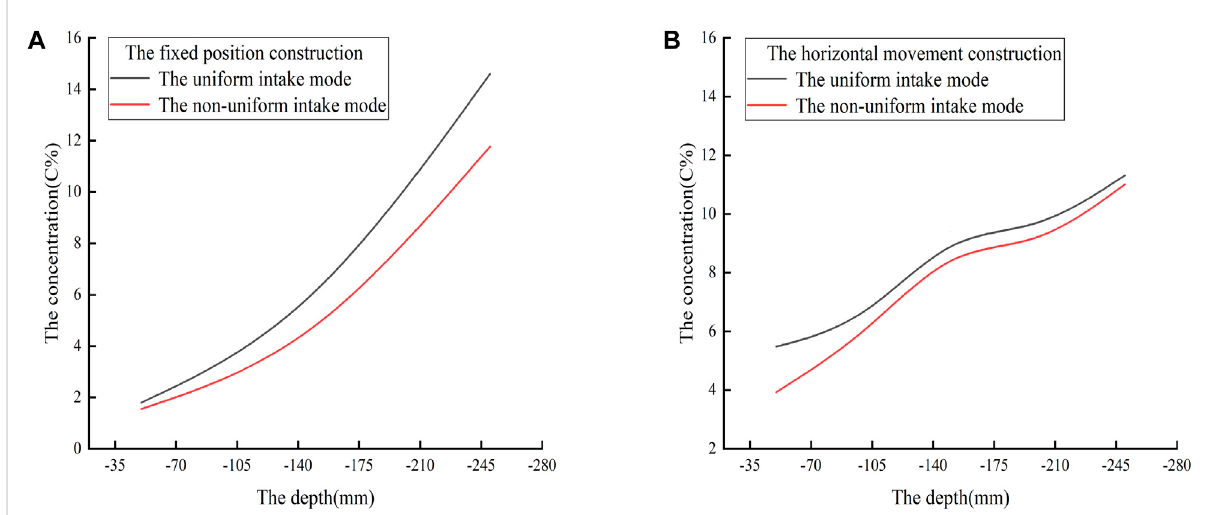
FIGURE 5 Variationofparticleconcentrationwithsanddepthunderdifferentintakemodes. (A) The fi xedpositionconstructionmethod. (B) Thehorizontal movement construction method.